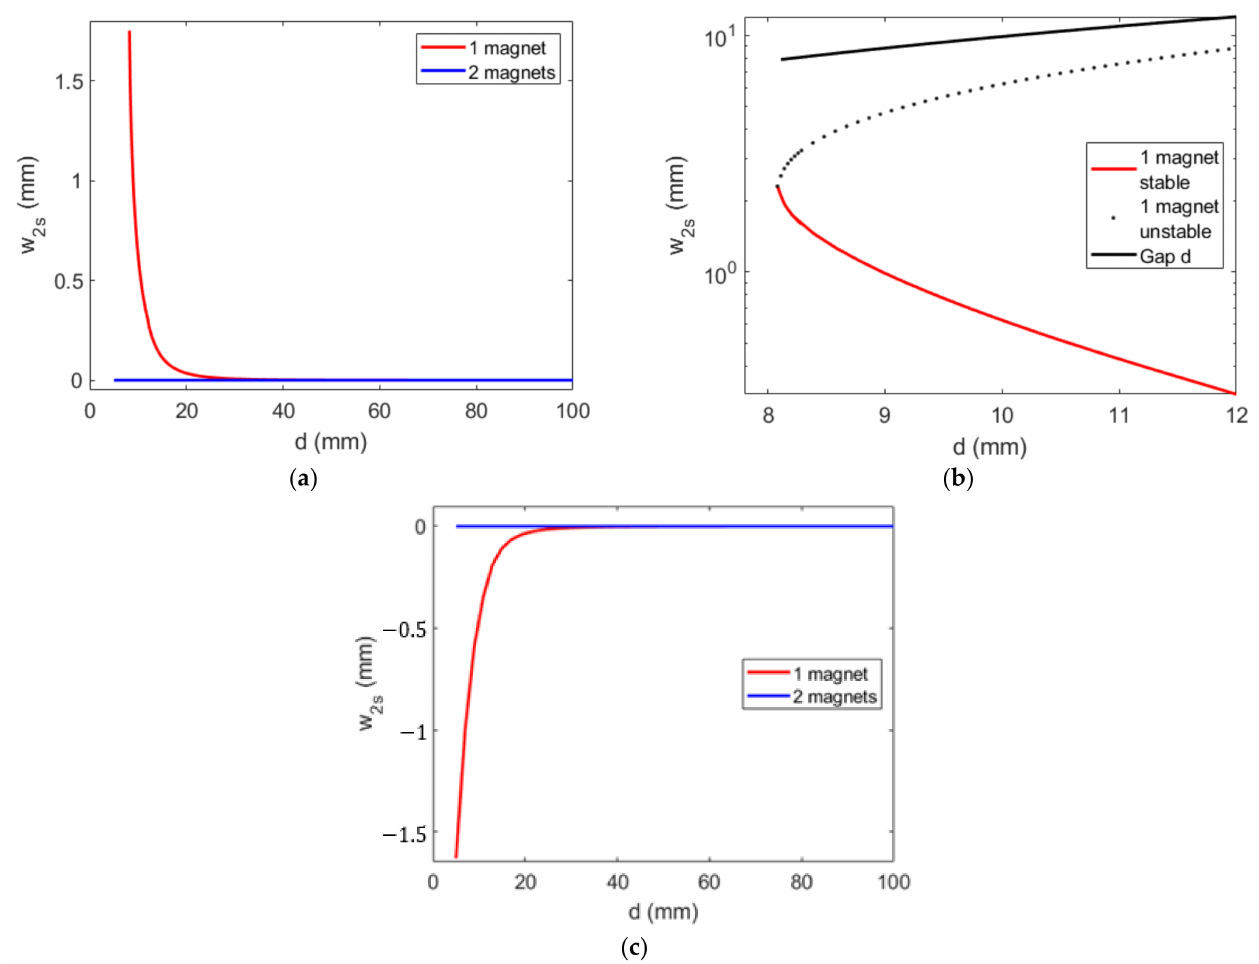
Figure 3. The effects of the magnetic forces on the static position of the absorber when the magnets are attractive in ( a ) linear and ( b ) log scale, and ( c )